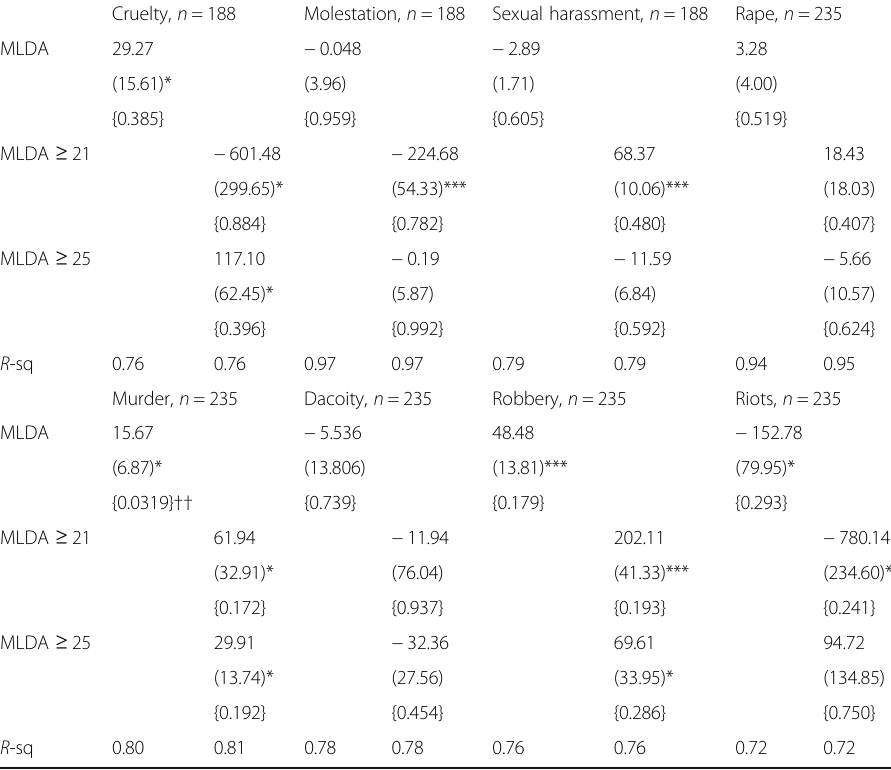
Table 10 The impact of alcohol regulation on crime in states never under prohibition